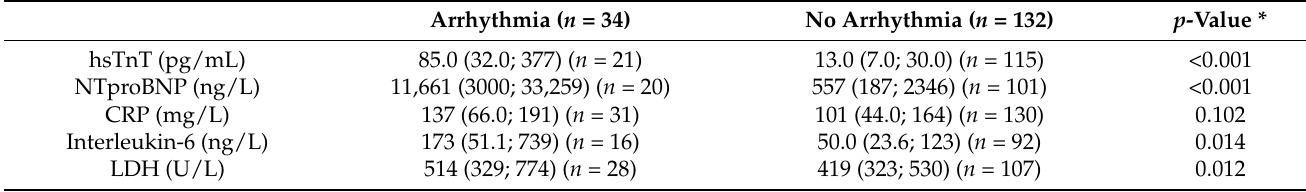
Table 2. Peak levels of cardiac and inflammatory biomarkers.